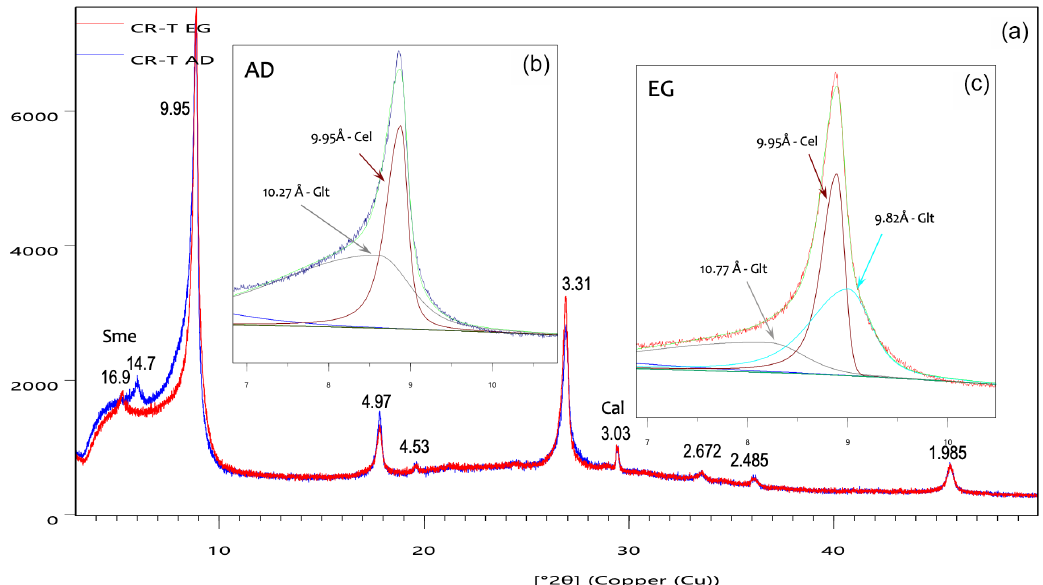
Figure 2. X-ray diffraction diagrams of the < 2µm fraction of the CR-T sample: (a) superposition of the diagrams corresponding to the air-dried (AD, blue) and ethylene-glycol-treated (EG, red) specimens, which show a clear change in the 10Å peak with the treatment; (b) decomposition of the air-dried specimen diagram; (c) decomposition of the EG treated specimen diagram. Sme – smectite; Cal – calcite; the rest of the peaks correspond to